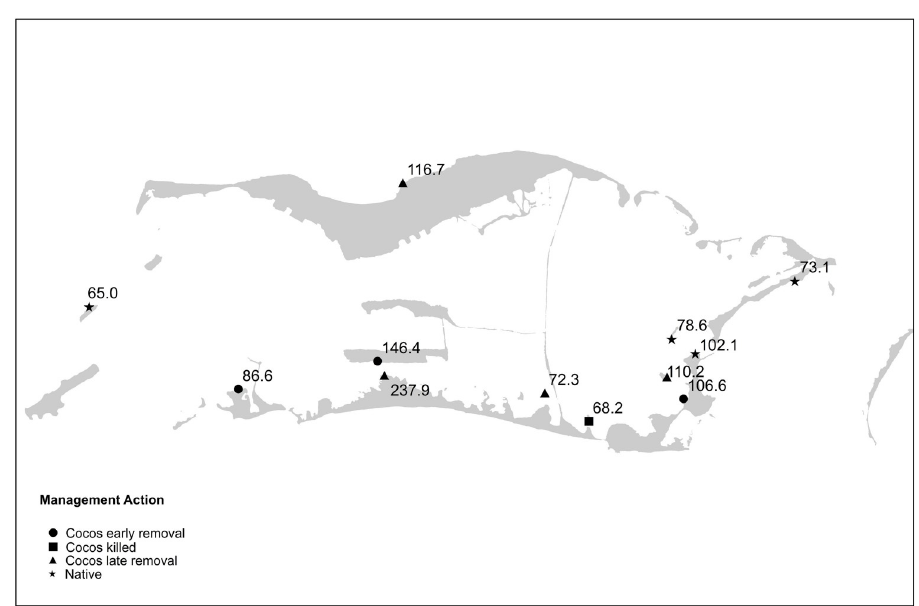
Fig 4. Map of DOC sampling results. On this map, different shapes symbolize different management actions under which the samples were taken; DOC, ( μ MC) measured at each site is indicated by a label. Basemap data depicting Palmyra Atoll islet locations is made available in the public domain from the USGS